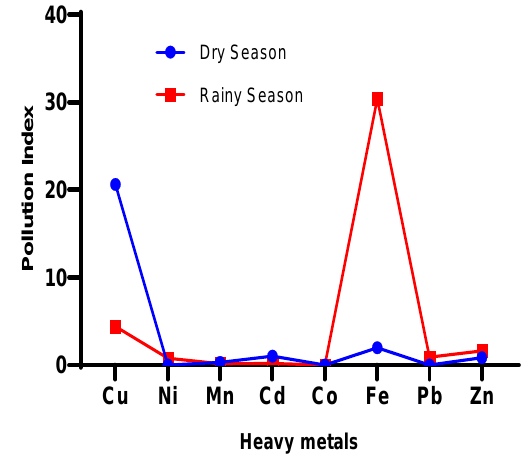
Fig. 2. Seasonal variation of Pollution index.